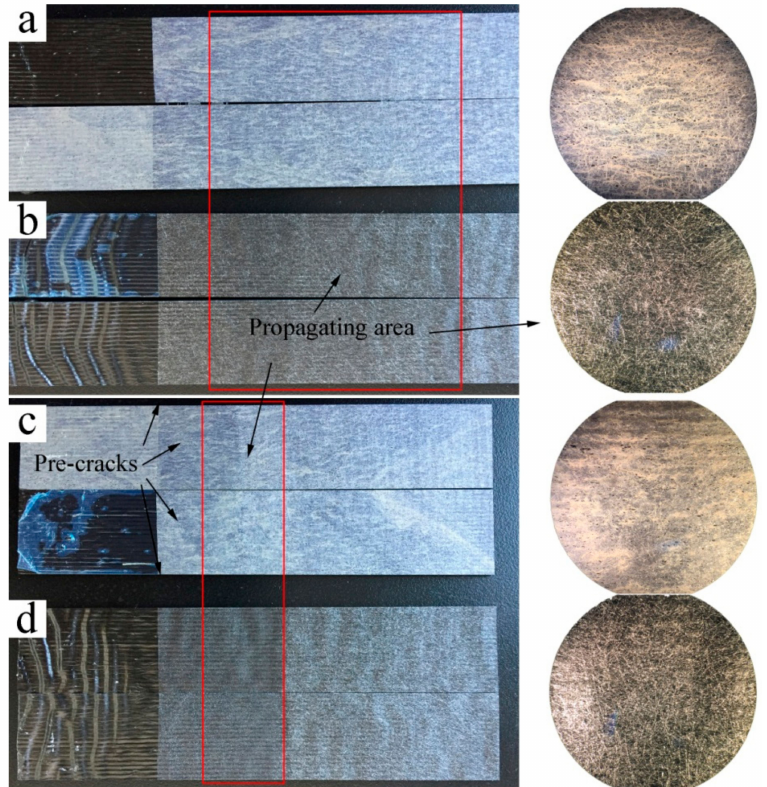
Figure 7. Optical photos and optical microscope photographs of failure surfaces after Mode I and Mode II fracture toughness test. ( a ) conductive papers interleaved, Mode I fracture surface; ( b ) plain papers interleaved, Mode I fracture surface; ( c ) conductive papers interleaved, Mode II fracture surface; ( d ) plain papers interleaved, Mode II fracture